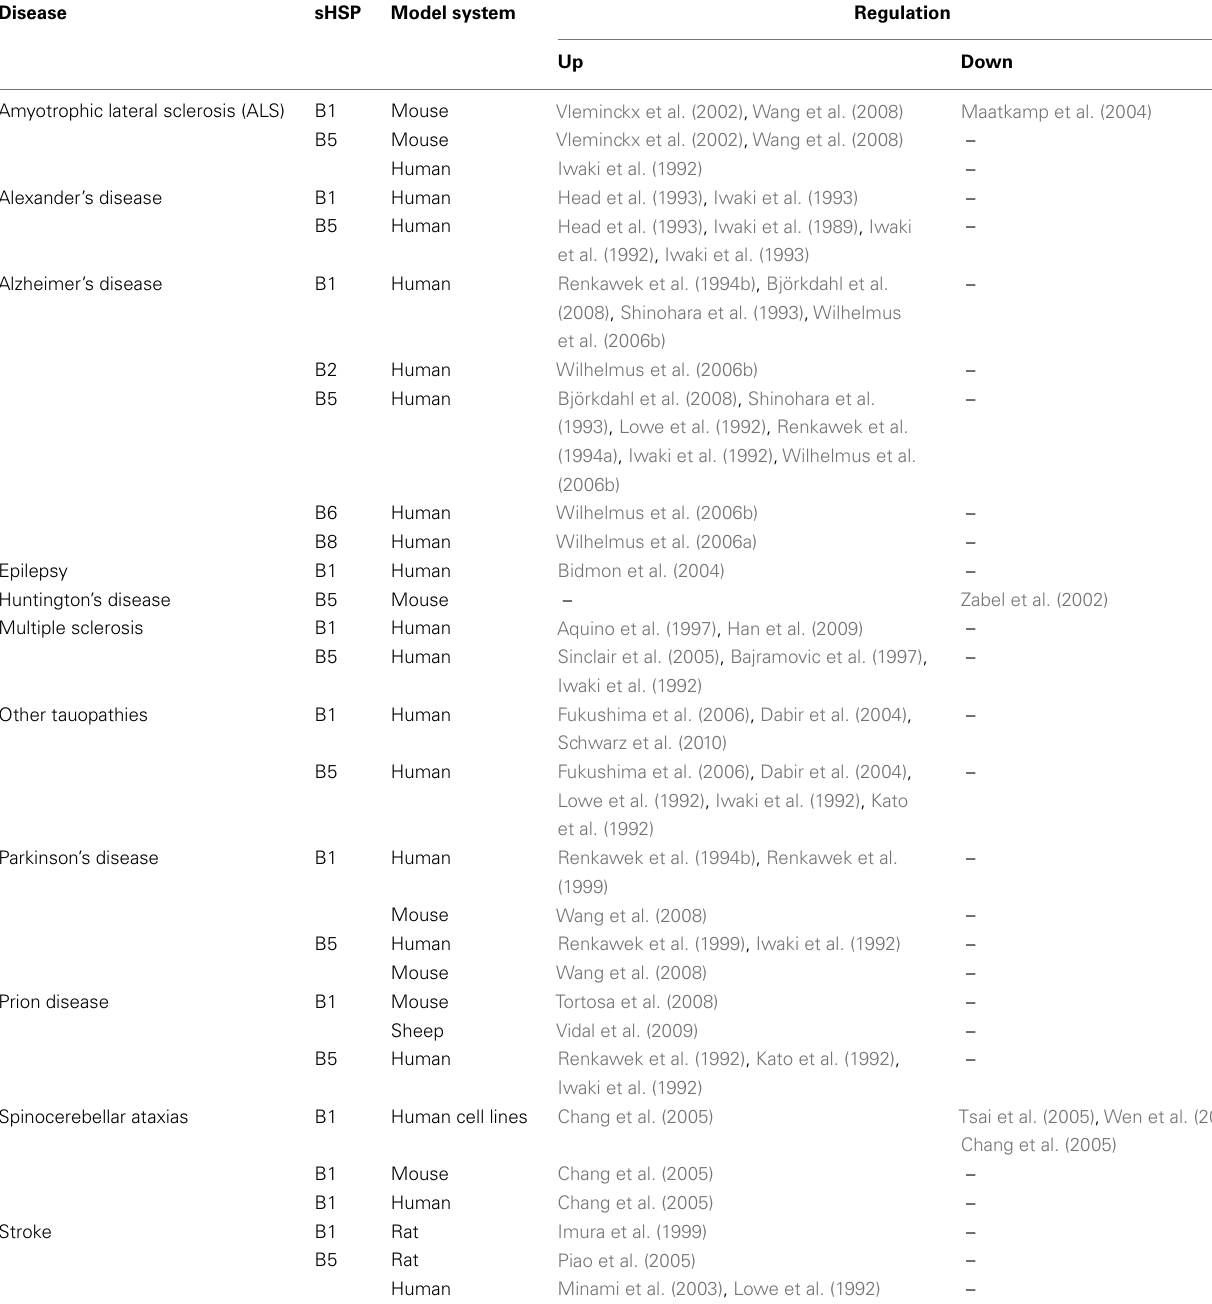
Table 2 | Small heat shock protein expression in human and rodent models of neurological